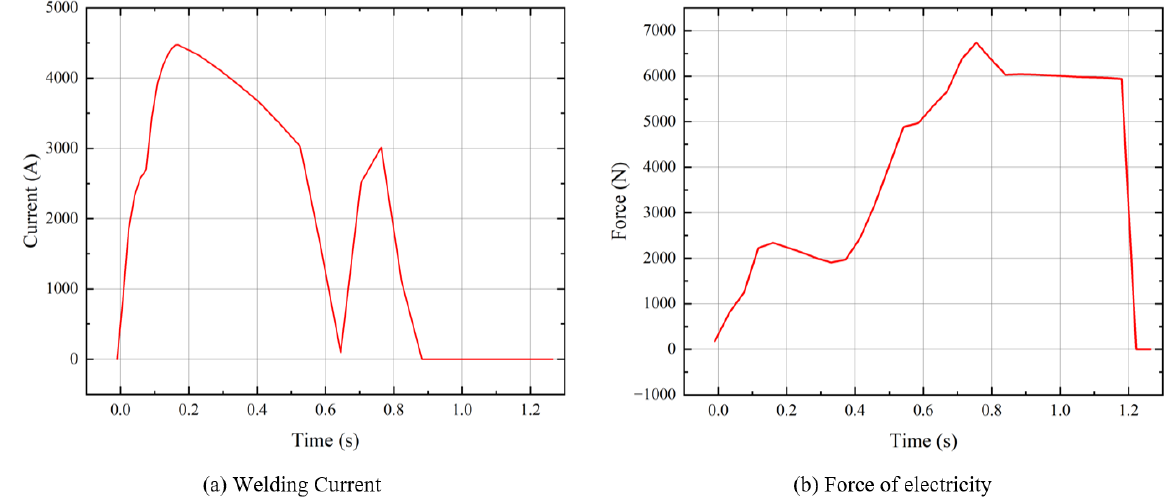
(b) Force of electricity Figure 8. Curves after wavelet threshold noise cancellation, welding current ( a ), force of electricity ( b ).